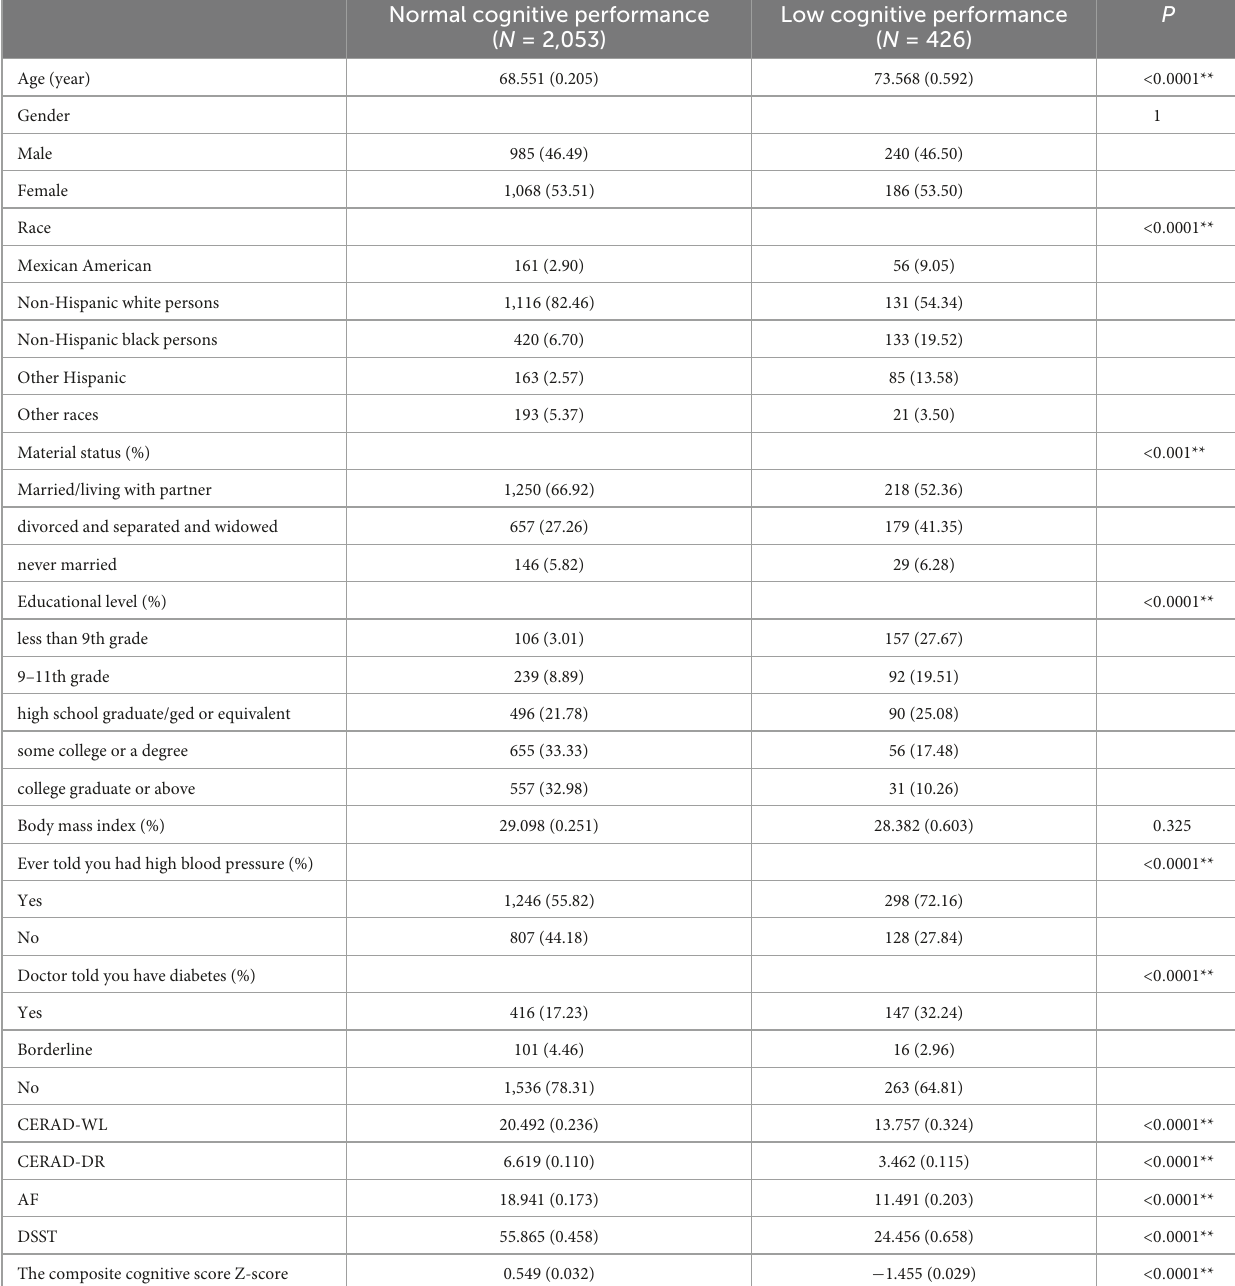
TABLE 1 Characteristics of participants [mean (SE)/N